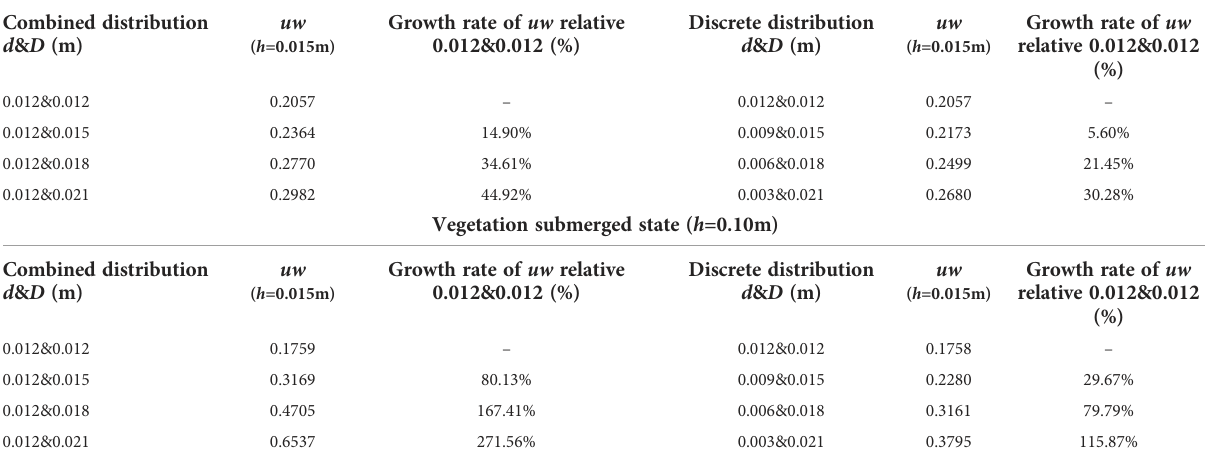
TABLE 3 The Reynolds stress uw value and its rate of change in speci fi c water depths at P 1 position under different submerging states and distribution modes. Vegetation non-submerged state ( h